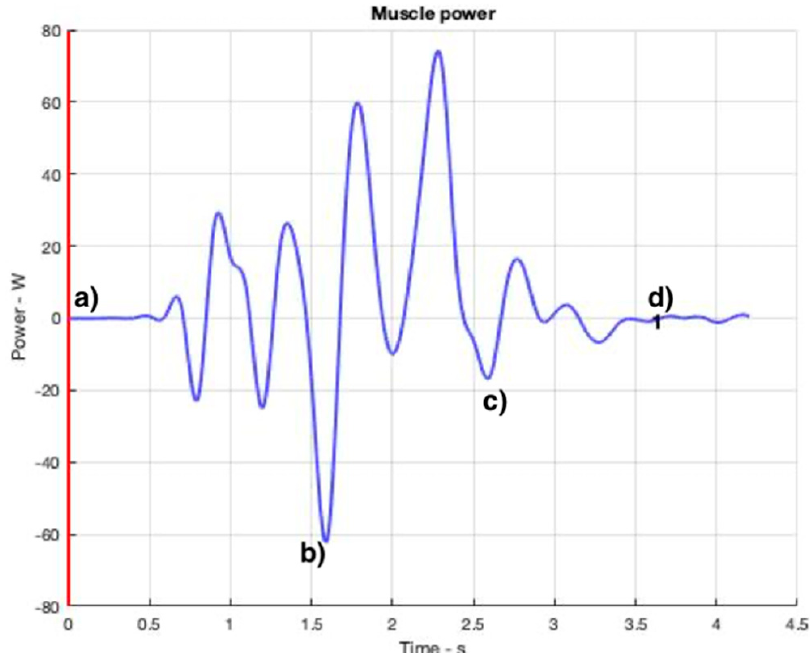
Figure 11. Total muscle power throughout the OTP. The instants corresponding to the four snapshots in Figure 6 are indicated from ( a – d ).